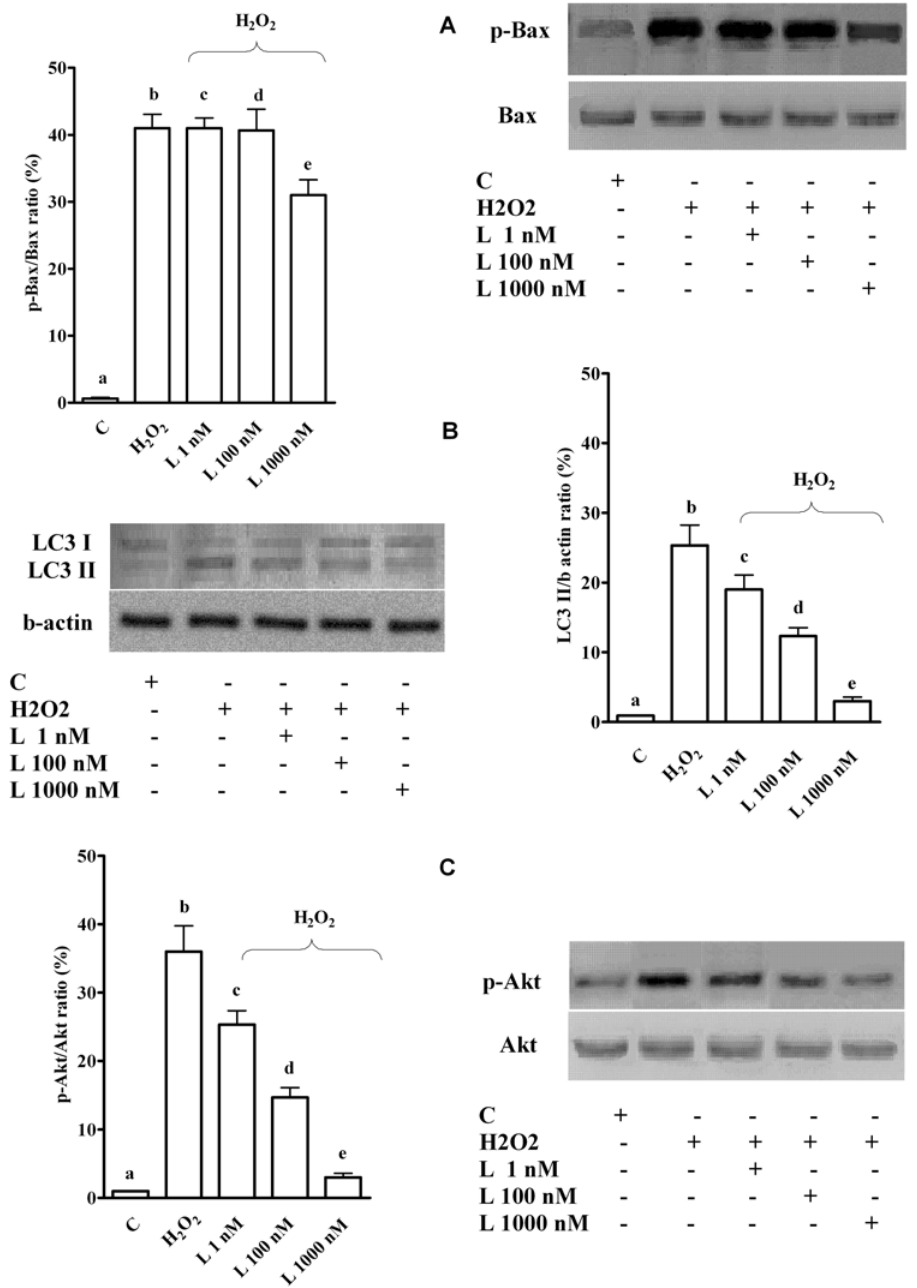
Fig 9. Effects of levosimendan on apoptosis, autophagy and cell survival signalling in LX-2 subjected to peroxidation. In A, B and C, effects of levosimendan on p-Bax, LC3I/II and p-Akt, respectively. Densitometric analysis of p-Bax, LC3II and p-Akt and an example of lanes taken in one of the 3 different experiments performed for each experimental protocol are reported. Abbreviations are as in Figs 1 – 7. In A, b, c, d, e P < 0.05 vs a; e P < 0.05 vs b, c, d. In B, b, c, d, e P < 0.05 vs a; c, d, e P < 0.05 vs b; d, e P < 0.05 vs c; e P < 0.05 vs d. In C, b, c, d, e P < 0.05 vs a; c, d, e P < 0.05 vs b; d, e P < 0.05 vs c; e P < 0.05 vs d. The results of densitometric analysis are expressed as means of 3 independent experiments (%) ± SD (indicated by the bars).